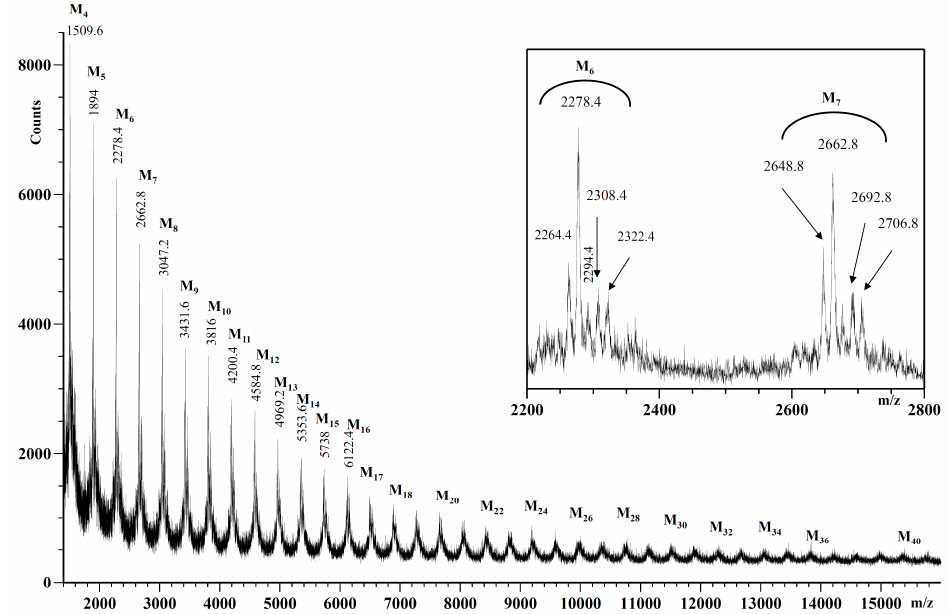
Figure 11. MALDI-TOF mass spectrum of poly-4’,6-PO- BF3k .